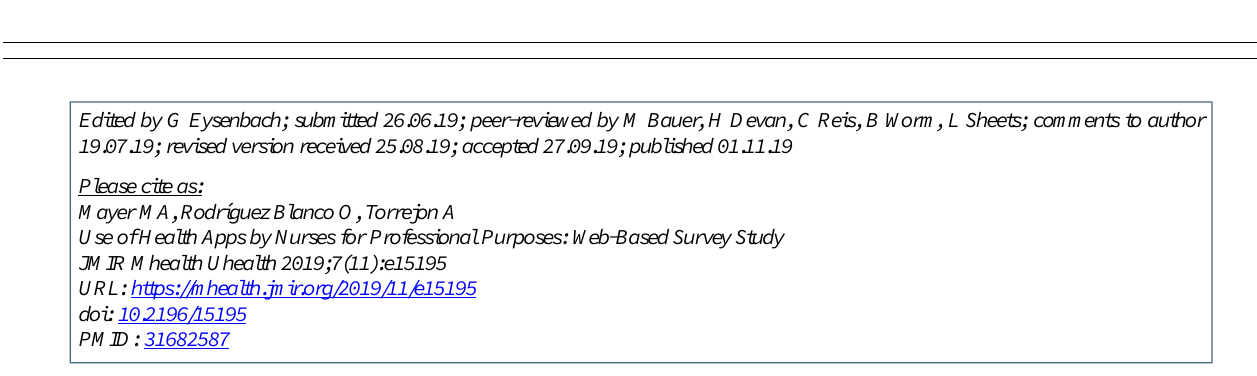
COIB: Nursing Association of